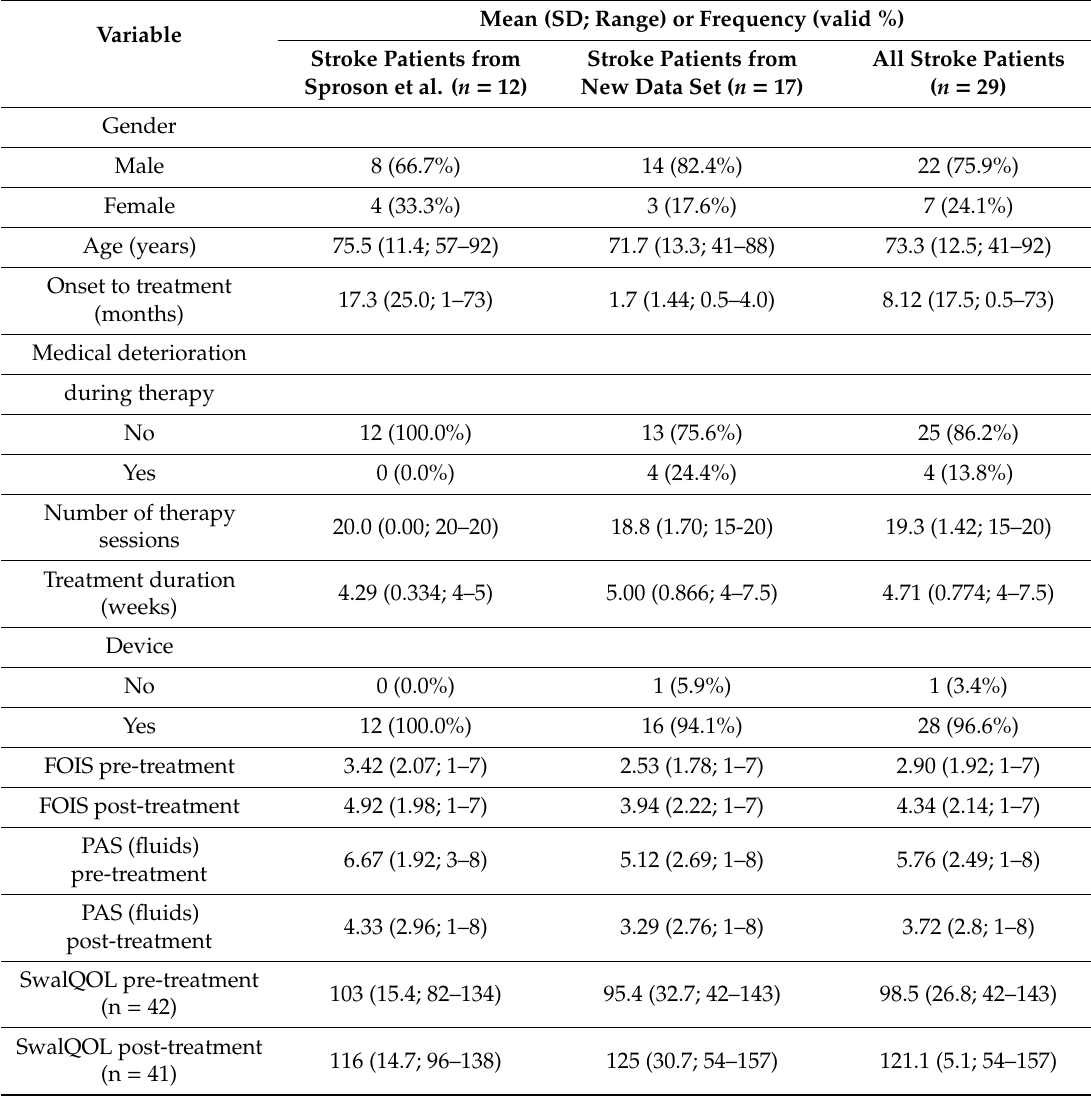
Table 3. Comparative summary of stroke patients (new data c.f. data from Sproson et al., 2018